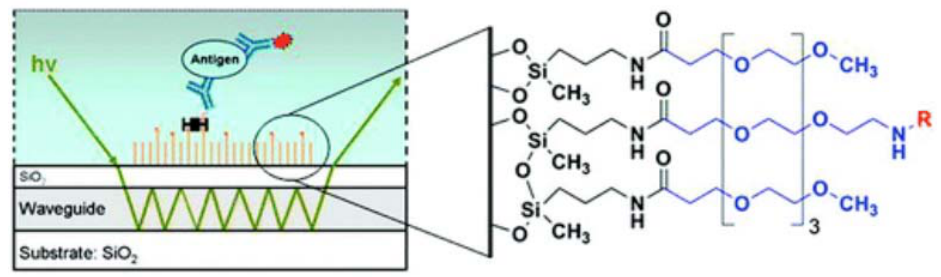
Figure 7. Chemistry of the Silane-based self-assembled monolayers used for waveguide functionalization (left) and a schematic representation of a waveguide-based sandwich immunoassay for biomarker detection used at